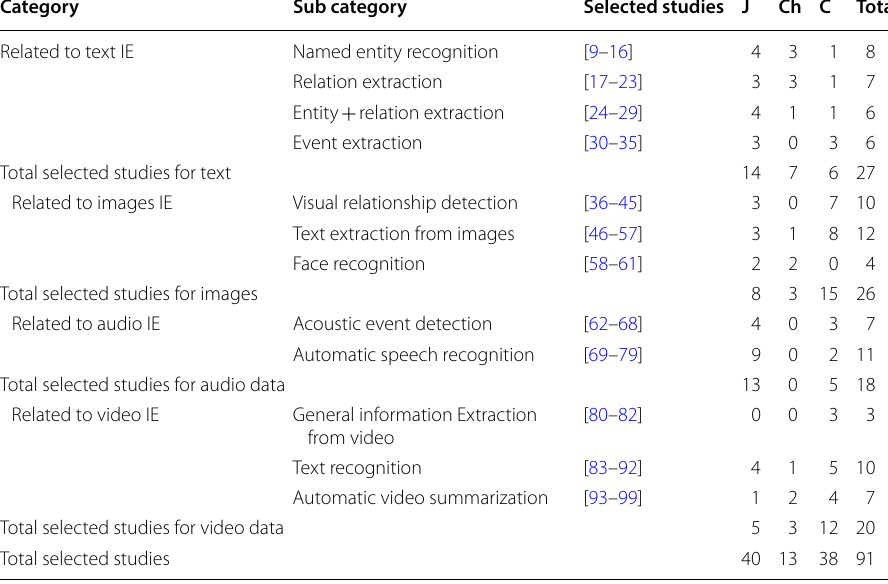
Table 3 Distribution of selected studies w.r.t study type and data